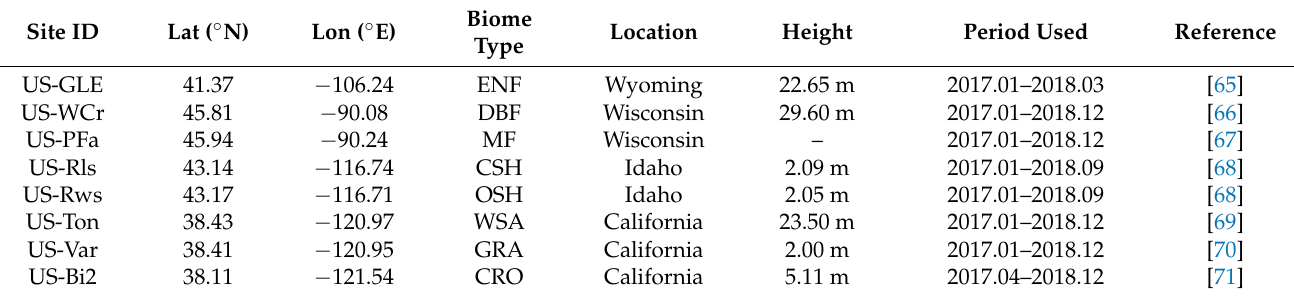
Table 1. List of AmeriFlux eddy covariance tower sites adopted within the